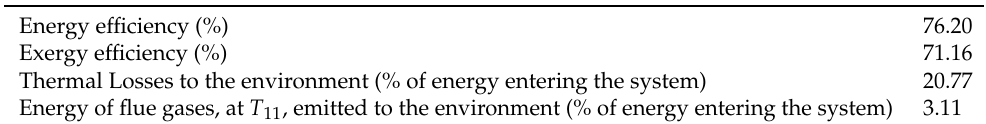
Table 3. Validation for the case of pure